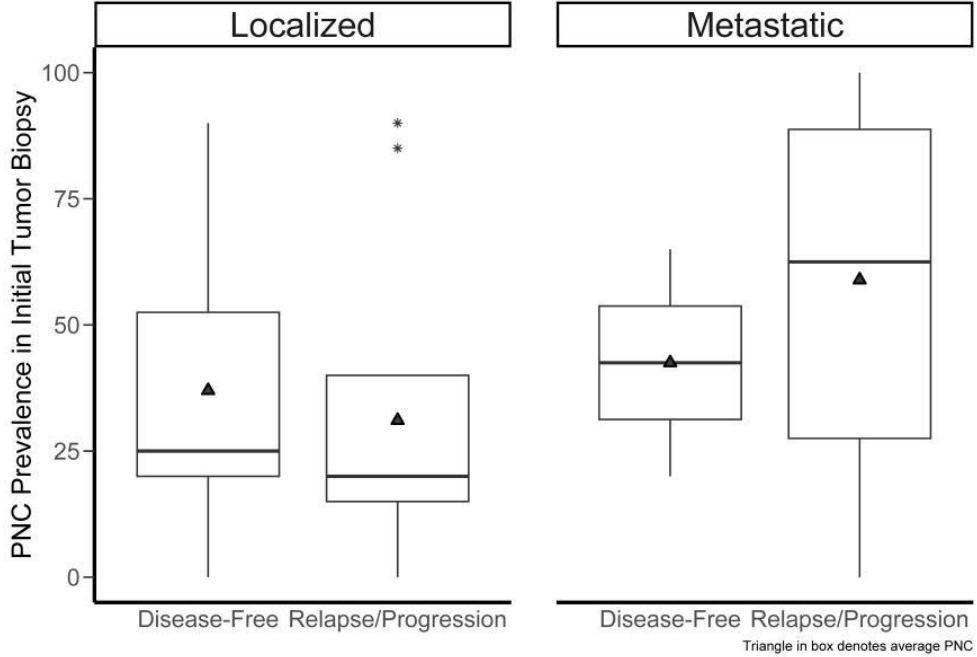
Figure 3. PNC prevalence change in initial tumor biopsy. Patients with metastatic disease and relapse and/or progression had an increased PNC prevalence compared with those who did not have such an event. Triangle is the average PNC per group. Horizontal bar in the box is the median value. The asterisks represent actual data points that are outliers.